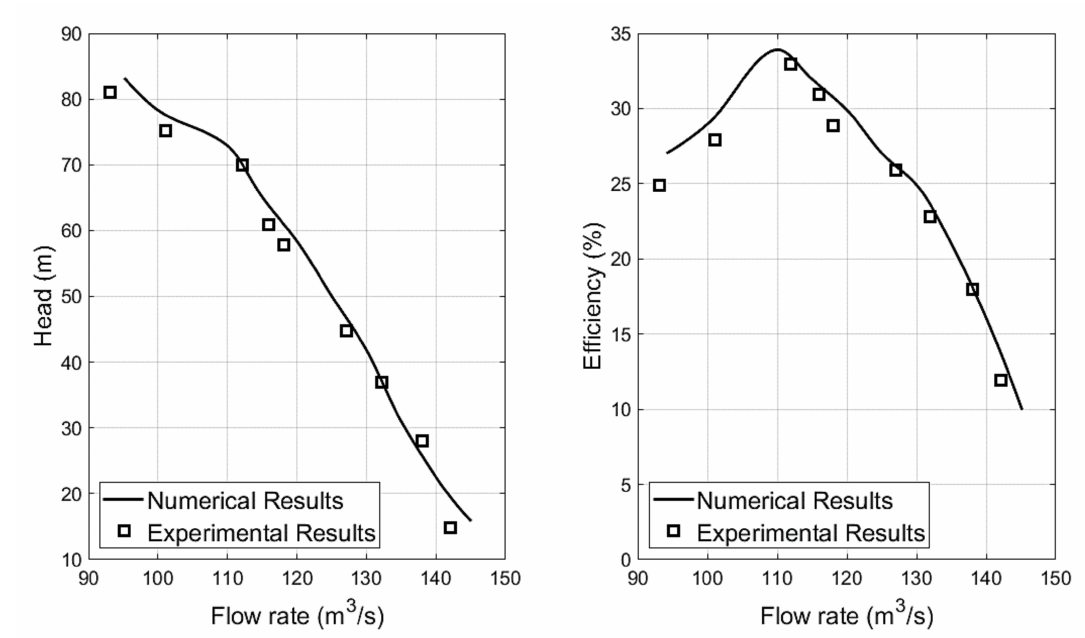
Figure 3. Comparison of experimental data and numerical results.